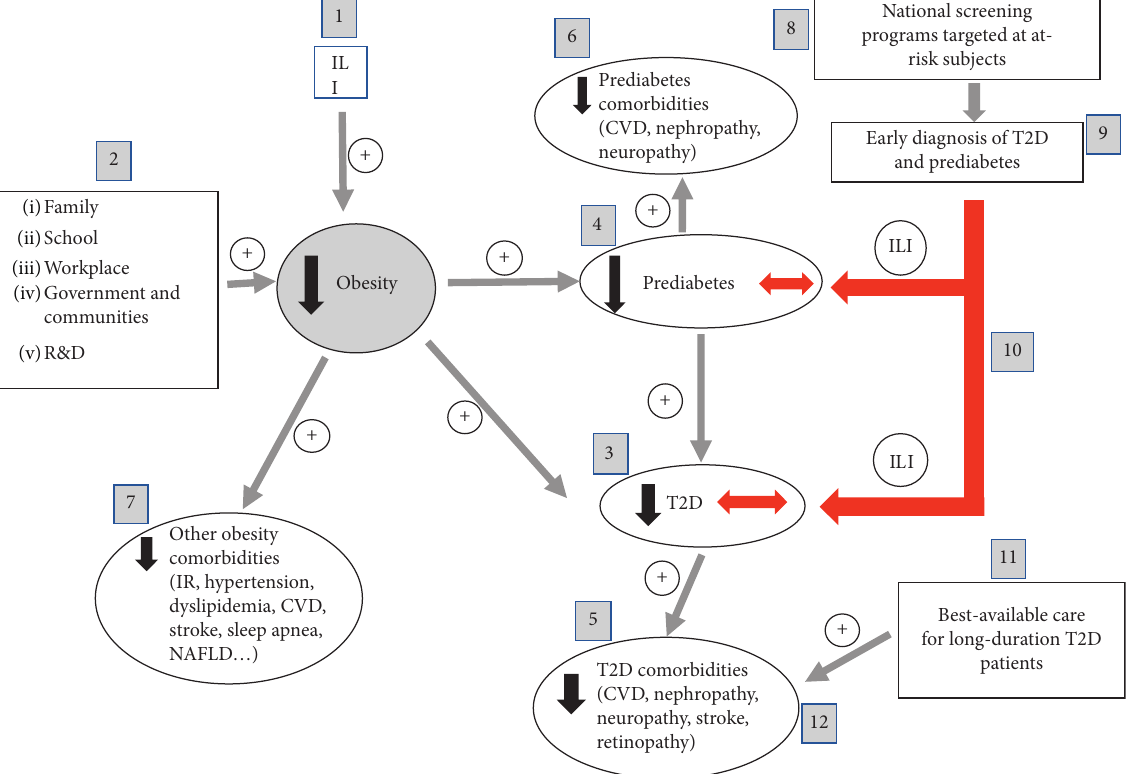
Figure 1: Concerted interventions required to curb diabetes and obesity epidemics. The battle against diabetes and obesity requires a holistic approach. Obesity rates can be reduced by intensive lifestyle intervention (ILI) (1) and prevented by concerted efforts between different partners, including family, school, workplace, government agencies, and research and development (2). Prevention of obesity will prevent and reduce the incidence of T2D (3) and prediabetes (4) and will ultimately prevent diabetes and prediabetes comorbidities ((5) and (6)). Prevention of obesity will also reduce other obesity-associated complications (7). On the other hand, national screening programs (8) targeted at at-risk individuals will permit the early identification of individuals with short-duration T2D and prediabetes (9). These subjects will be enrolled in ILI programs to try to reverse conditions (10). Finally, individuals with long-duration T2D need to be provided with the best available management and care (11) to prevent, or at least delay, T2D-associated complications (12). The downward black arrows indicate prevention and reduction of incidence. The red left-right arrows indicate reversion of the conditions. The+sign indicates a positive effect. ILI: intensive lifestyle intervention; T2D: type 2 diabetes; IR: insulin resistance; CVD: cardiovascular disease; NAFLD: nonalcoholic fatty liver